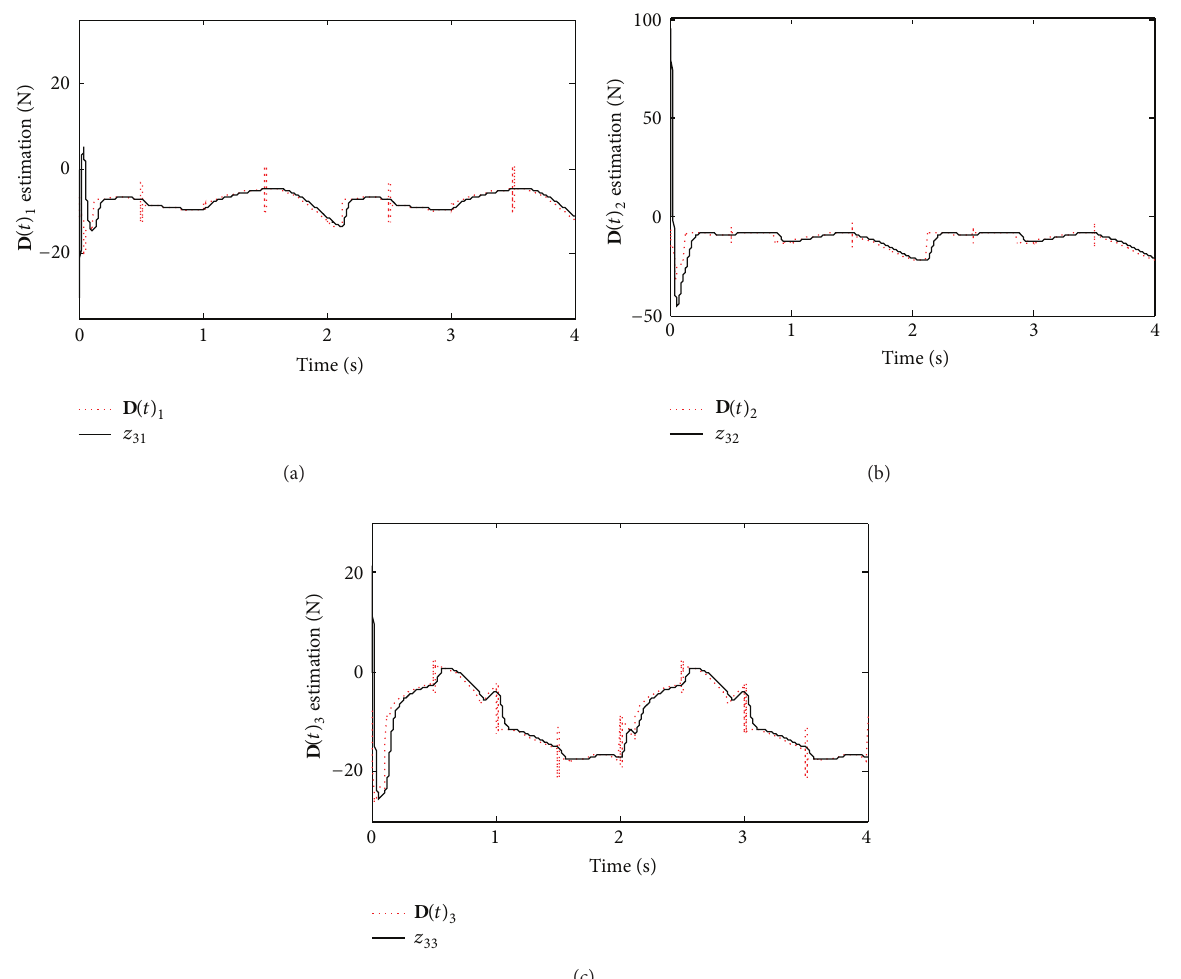
Figure 7: (a) Disturbance estimation of D (𝑡) 1 , (b) disturbance estimation of D (𝑡) 2 , and (c) disturbance estimation of D (𝑡) 3 .